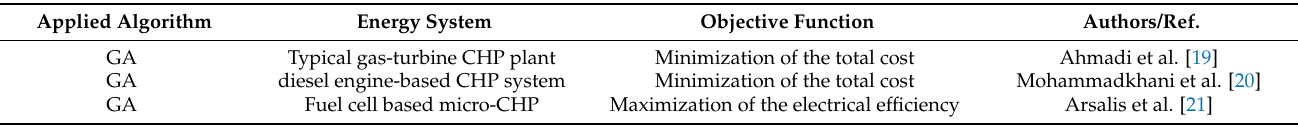
Table 3. Single-objective designing issues of CHP energy systems.